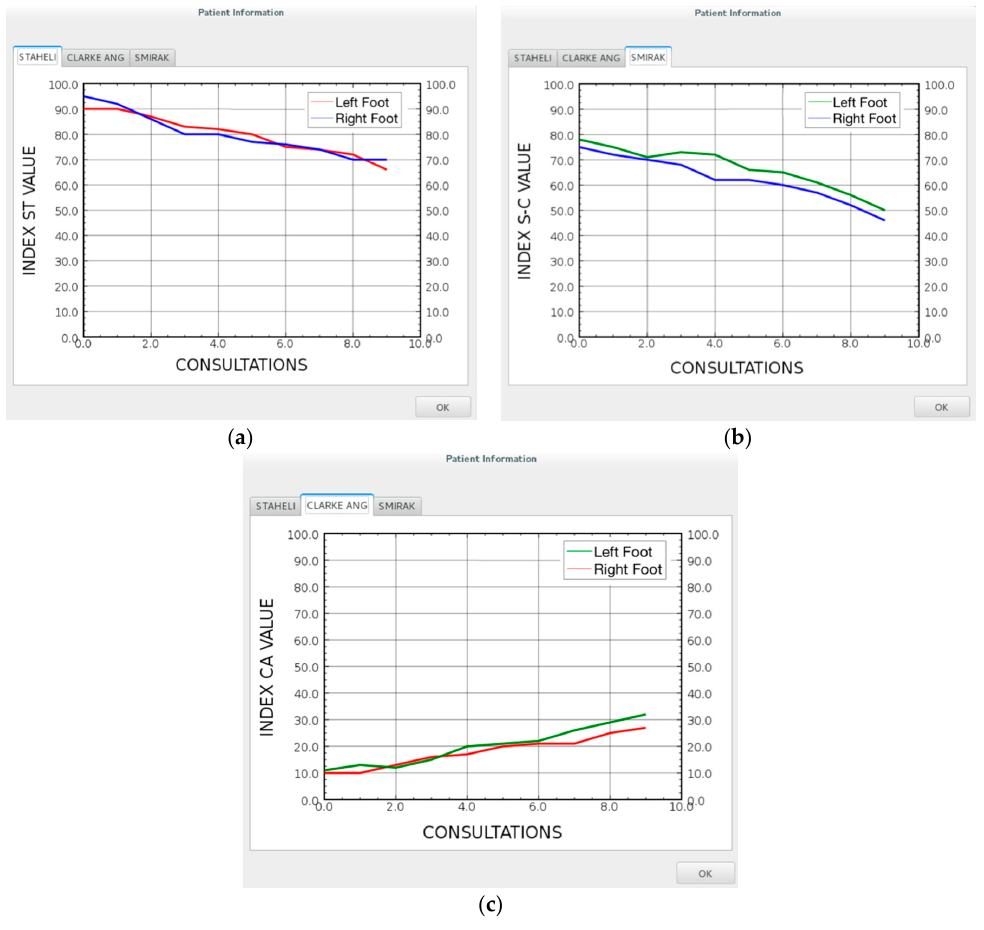
Figure 11. An example plots of a patient improvement over time with the evaluation of different parameters: ( a ) Staheli Index; ( b ) Chippaux-Smirak Index; ( c ) Clarke’s Angle. parameters: ( a ) Staheli Index; ( b ) Chippaux-Smirak Index; ( c ) Clarke’s